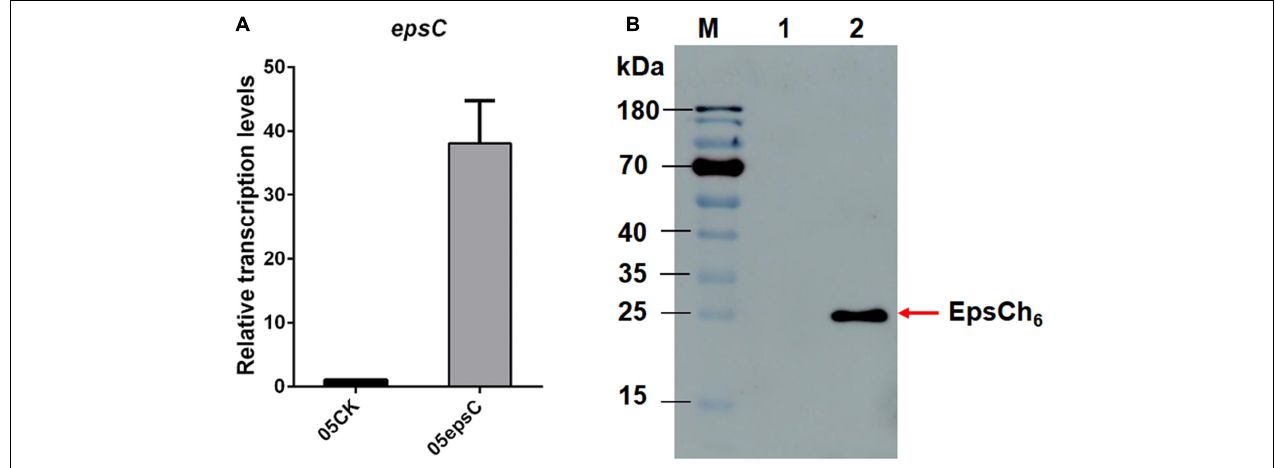
FIGURE 1 | The over-expression of epsC in S. thermophilus 05-34. (A) RT-qPCR analysis of the transcription level of epsC in S. thermophilus 05epsC. The fold change calculated was relative to the transcript levels in S. thermophilus 05epsC compared with that in 05CK. They were normalized using 16S rRNA gene as an internal control. Data are reported as mean ± SD from three independent experiments. (B) Detection of the over-expression of EpsC in S. thermophilus by Western blotting. M: PageRuler Prestained Protein Ladder (Thermo Fisher Scientific, Waltham, MA, United States). Lane 1: Protein sample extracted from S. thermophilus 05CK; Lane 2: Protein sample extracted from S. thermophilus 05epsCh 6